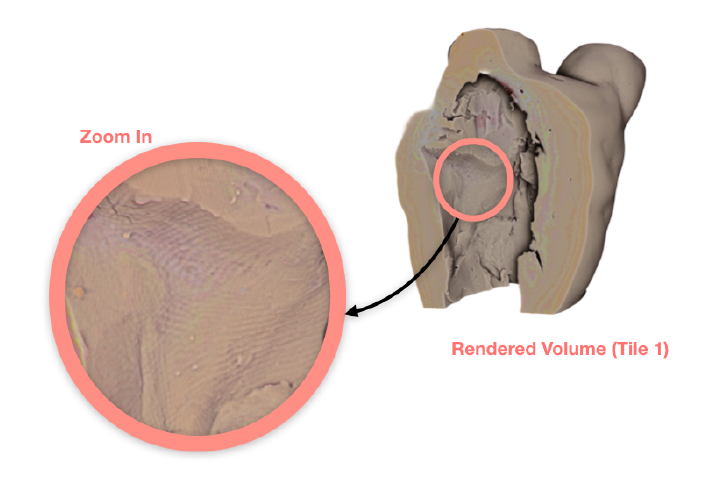
Figure 9. Distorted (suspected) fingerprints on the interior of the sample.